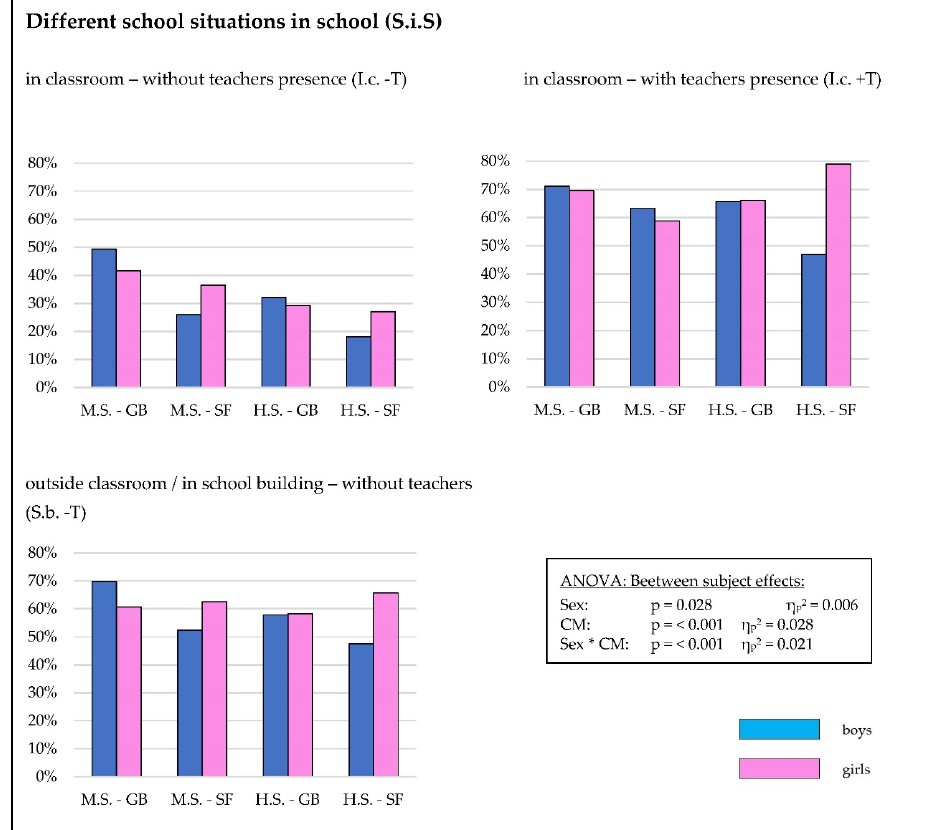
Figure 3. Detailed percentage of self-estimated correct mask wearing for the CM subgroups (class membership: M.S. GB, M.S. SF, H.S. GB, and H.S. SF) and sex ( ♂ = boys, ♀ = girls).